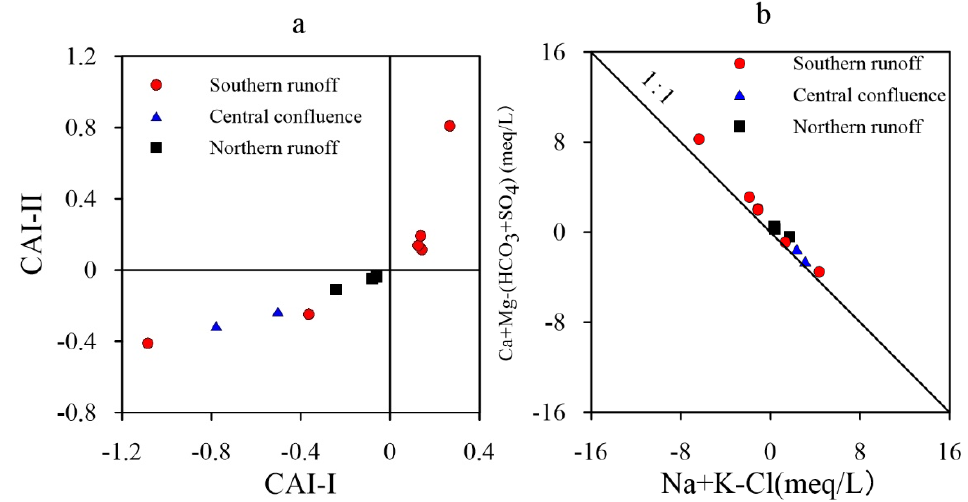
Figure 11. ( a ) CAI-I and CAI-II for ( b ) [(Ca+Mg)-(HCO 3 +SO 4 )] and [(Na+K)-Cl] in groundwater.